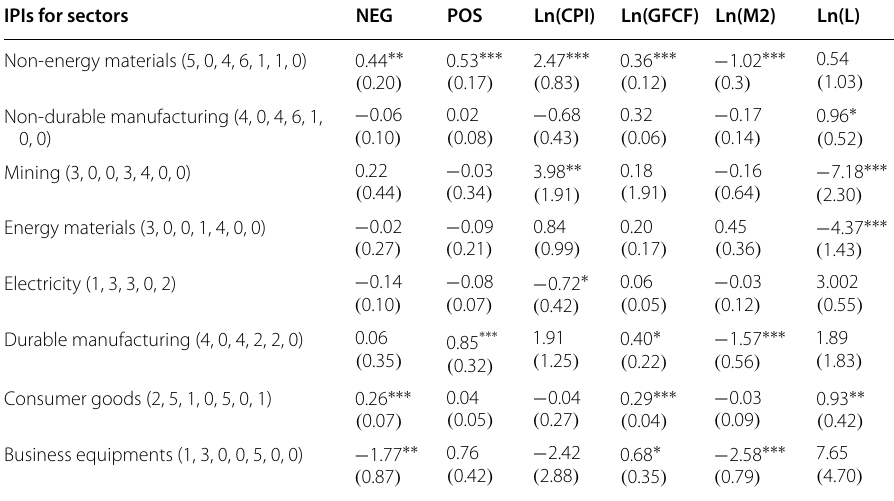
Table 3 Long-run NARDL estimates